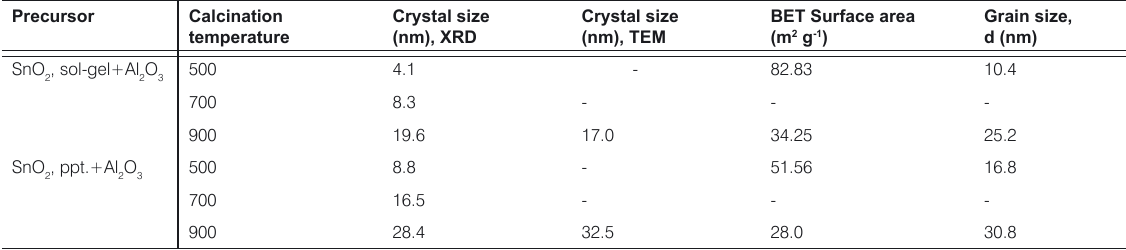
powders calcined at different 2